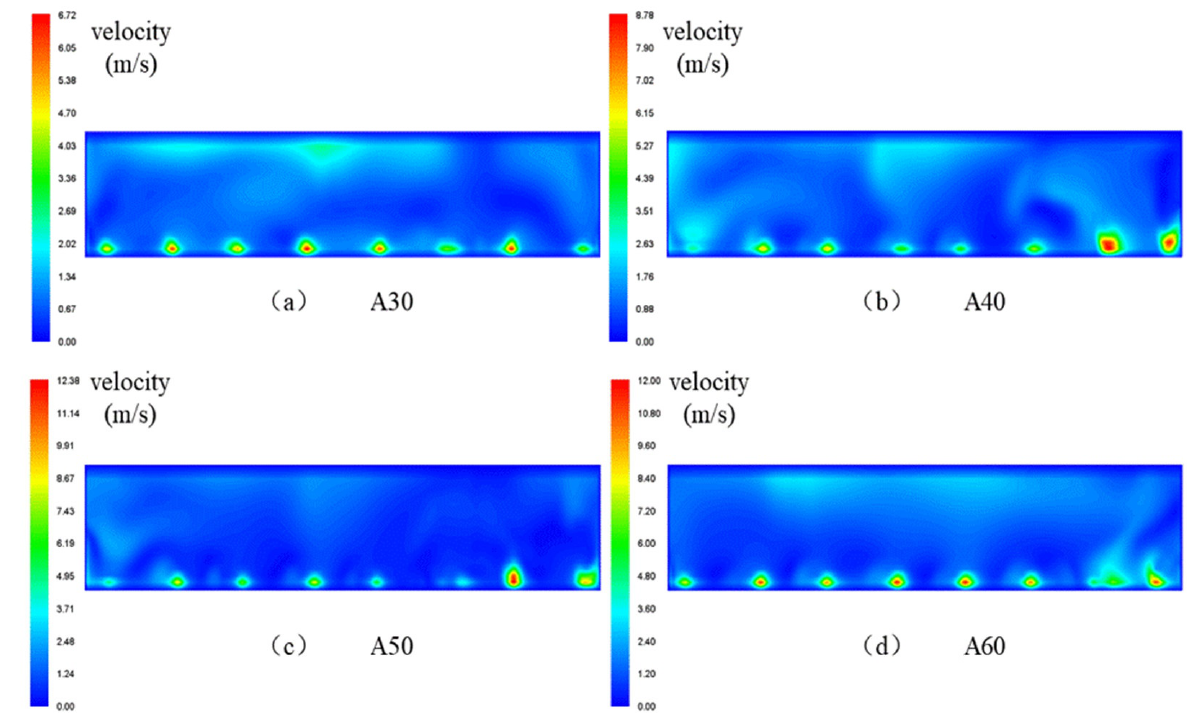
Figure 4. Velocity nephogram of vertical section at the grate tail of A30–A60.